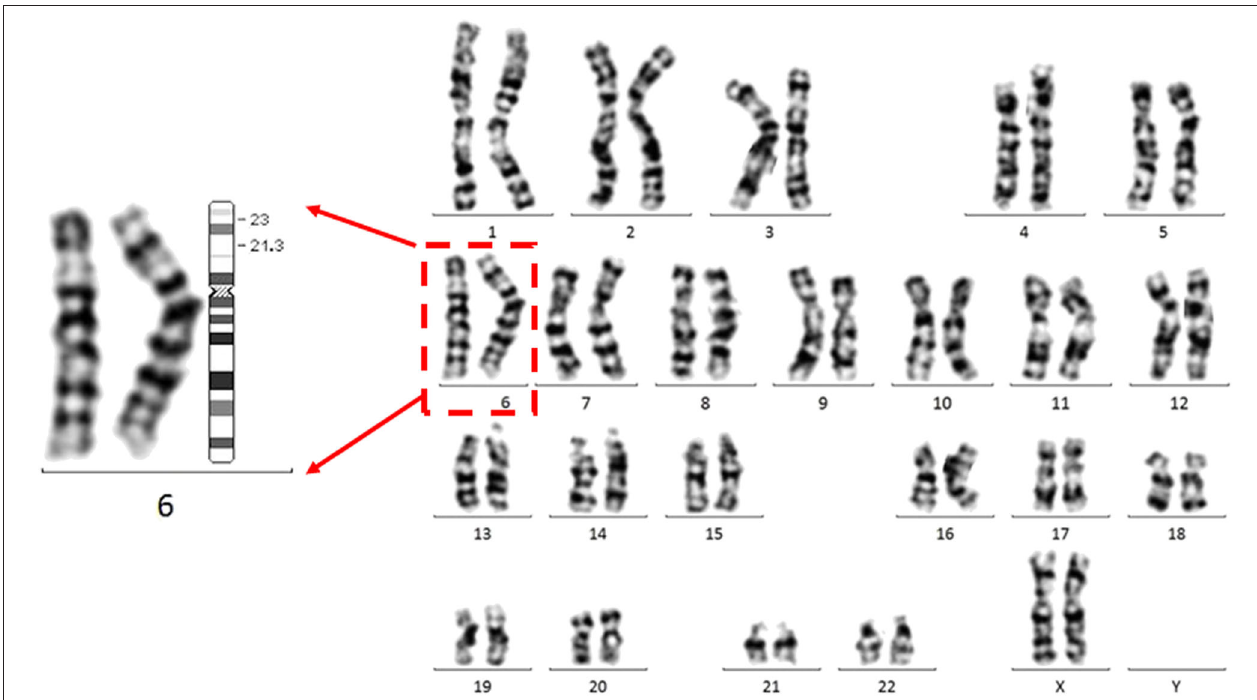
FIGURE 3 | The proband carries a chromosomal inversion in chromosome 6.Representative G banded chromosomes from the proband. Enlarged chromosome 6 is shown at the left. The karyotype represents a p21.3 in chromosome 6 invasion with p23 < 46, XX, inv (6) (p21.3p23) > . An ideogram of chromosome 6 is shown. The breakpoints are indicated in the ideogram.